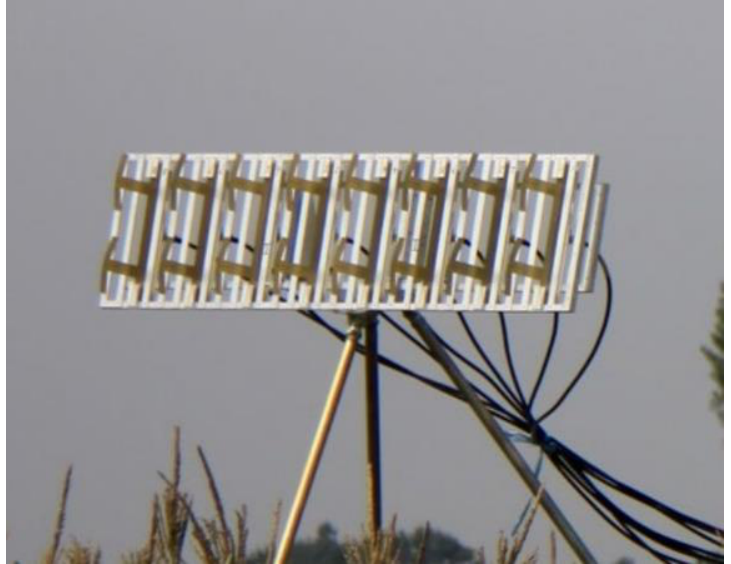
Figure 11. Photograph of radar receiving antenna.